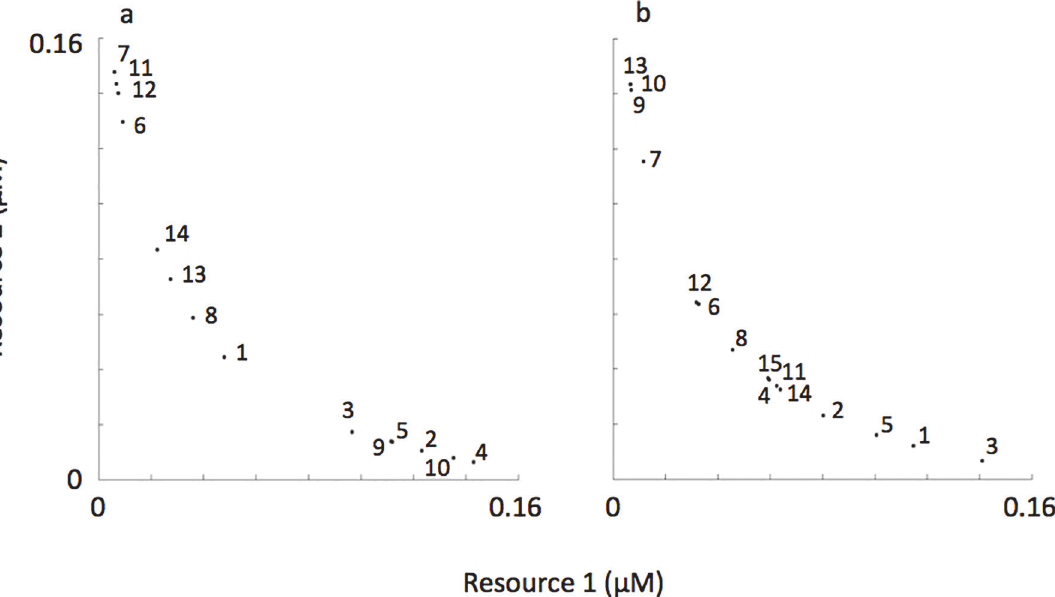
Fig 5. R * s of representative self-organized phytoplankton assemblages shown in Fig. 4 where reversals in the resource supply concentrations were sudden (a) and gradual (b). The numbers on the figure panels coincide with the species keys shown in Fig. 4A,